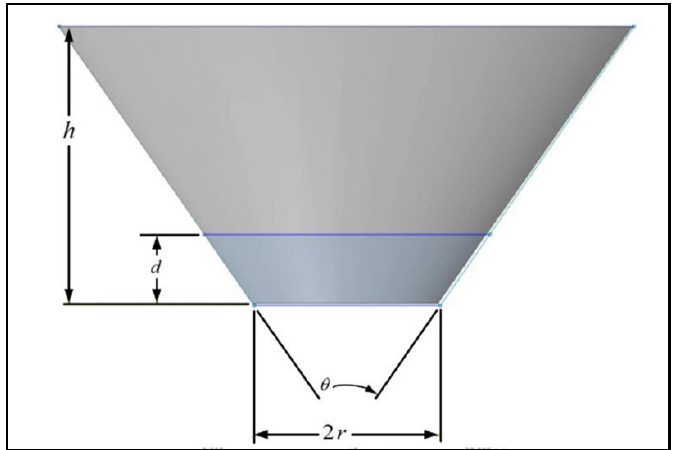
Figure 5. Sketch of the truncated cone buoy.